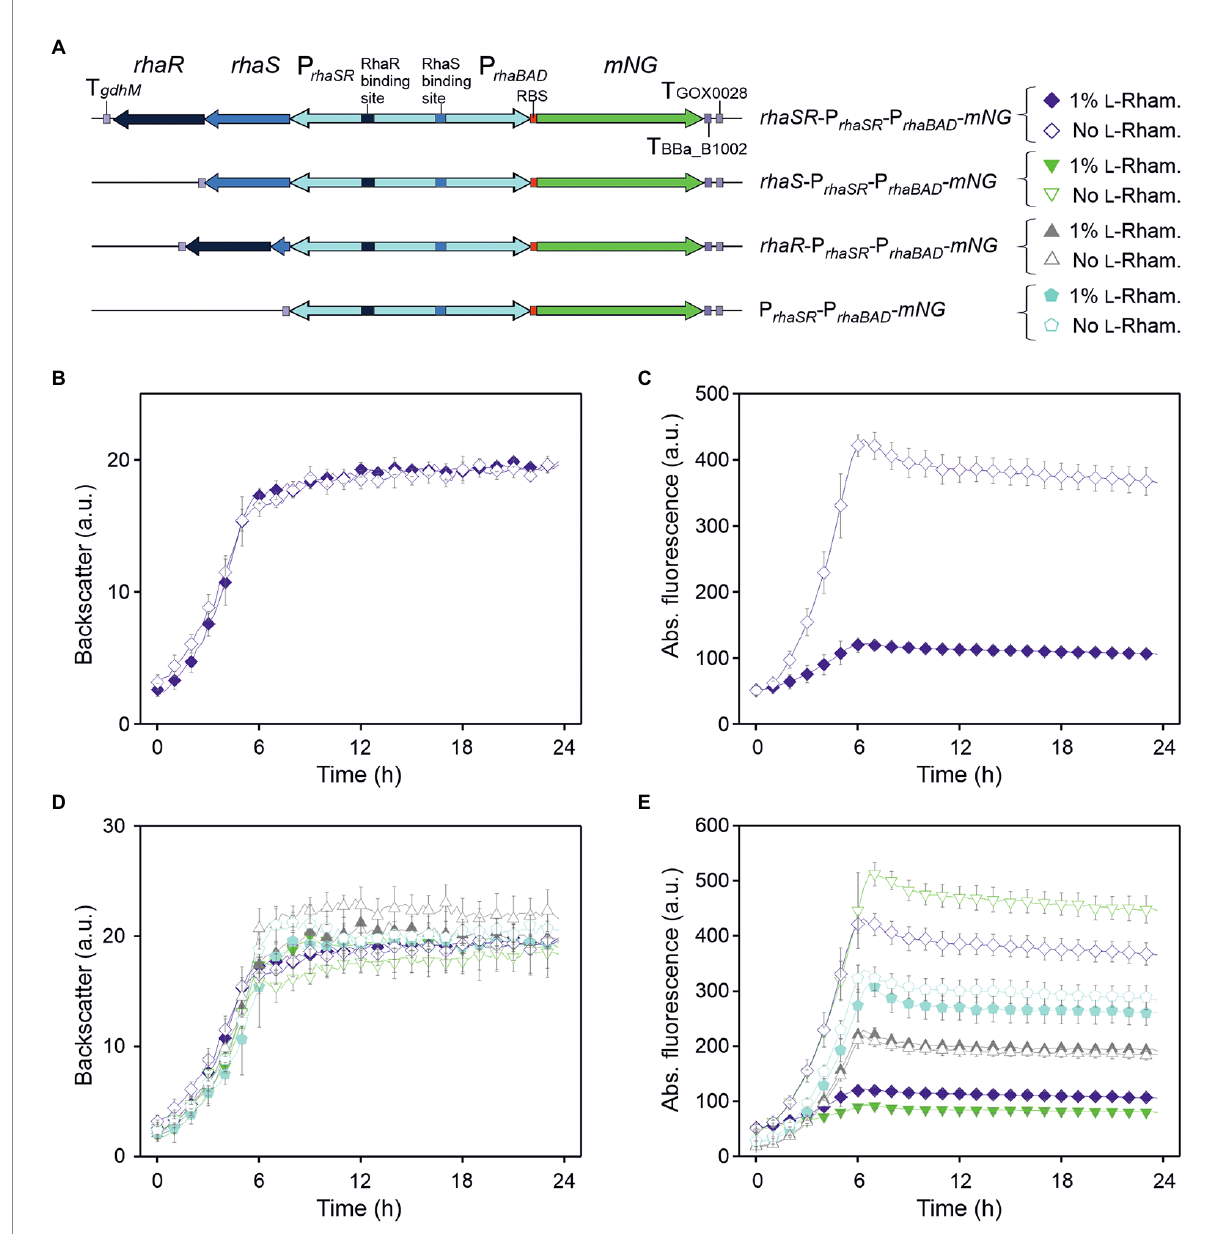
FIGURE 1 pBBR1MCS-5-based expression plasmids and analysis of the regulation of the RhaSR-P rhaBAD system from Escherichia coli in G. oxydans 621H. (A) Schematic illustration of the plasmid variants with reporter gene mNG used to test l -rhamnose-dependent regulation of P rhaBAD -derived expression in the presence and absence of RhaS and RhaR. T gdhM : terminator sequence of gdhM (GOX0265); T GOX0028 : terminator sequence of GOX0028. The RBS 5 ′ -AGGAGA was inserted in the 3 ′ region of P rhaBAD upstream from mNG . (B) Growth according to backscatter and (C) absolute mNG fluorescence in G. oxydans carrying plasmid pBBR1MCS-5- rhaSR -P rhaSR -P rhaBAD - mNG grown in d -mannitol medium without and with 1% (w/v) l -rhamnose in BioLector microscale. (D) Growth according to backscatter and (E) absolute mNG fluorescence of G. oxydans carrying either plasmid pBBR1MCS-5- rhaSR -P rhaSR -P rhaBAD - mNG , or a plasmid lacking either rhaR , or rhaS , or both rhaSR . Cells were grown in microscale (BioLector) in d -mannitol medium without and with 1% (w/v) l -rhamnose. All data represent mean values and standard deviation from two biological replicates (clones) with three technical replicates each. BioLector settings: backscatter gain 20, fluorescence gain